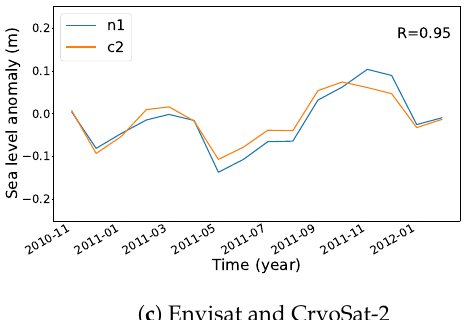
Figure 2. Monthly median of the entire Arctic in the overlapping periods for ( a ) ERS-1 (e1) and ERS-2 (e2), ( b ) ERS-2 and Envisat (n1) and ( c ) Envisat and CryoSat-2 (c2). In the top right corner of each figure the correlation coefficient is